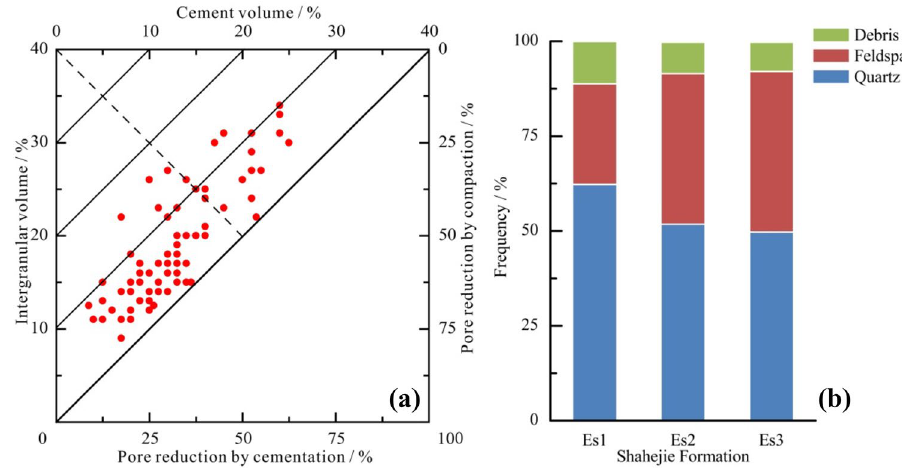
dissolution in grains, cast thin section; f Well L70-93, 3362.84 m, feldspar dissolution, formation of super pores, dissolution of soluble components in rock cuttings, thin cast body; g: Well L487, 3683.95 m, carbonate cementation, cast thin section; h Well L70-114, 3825.56